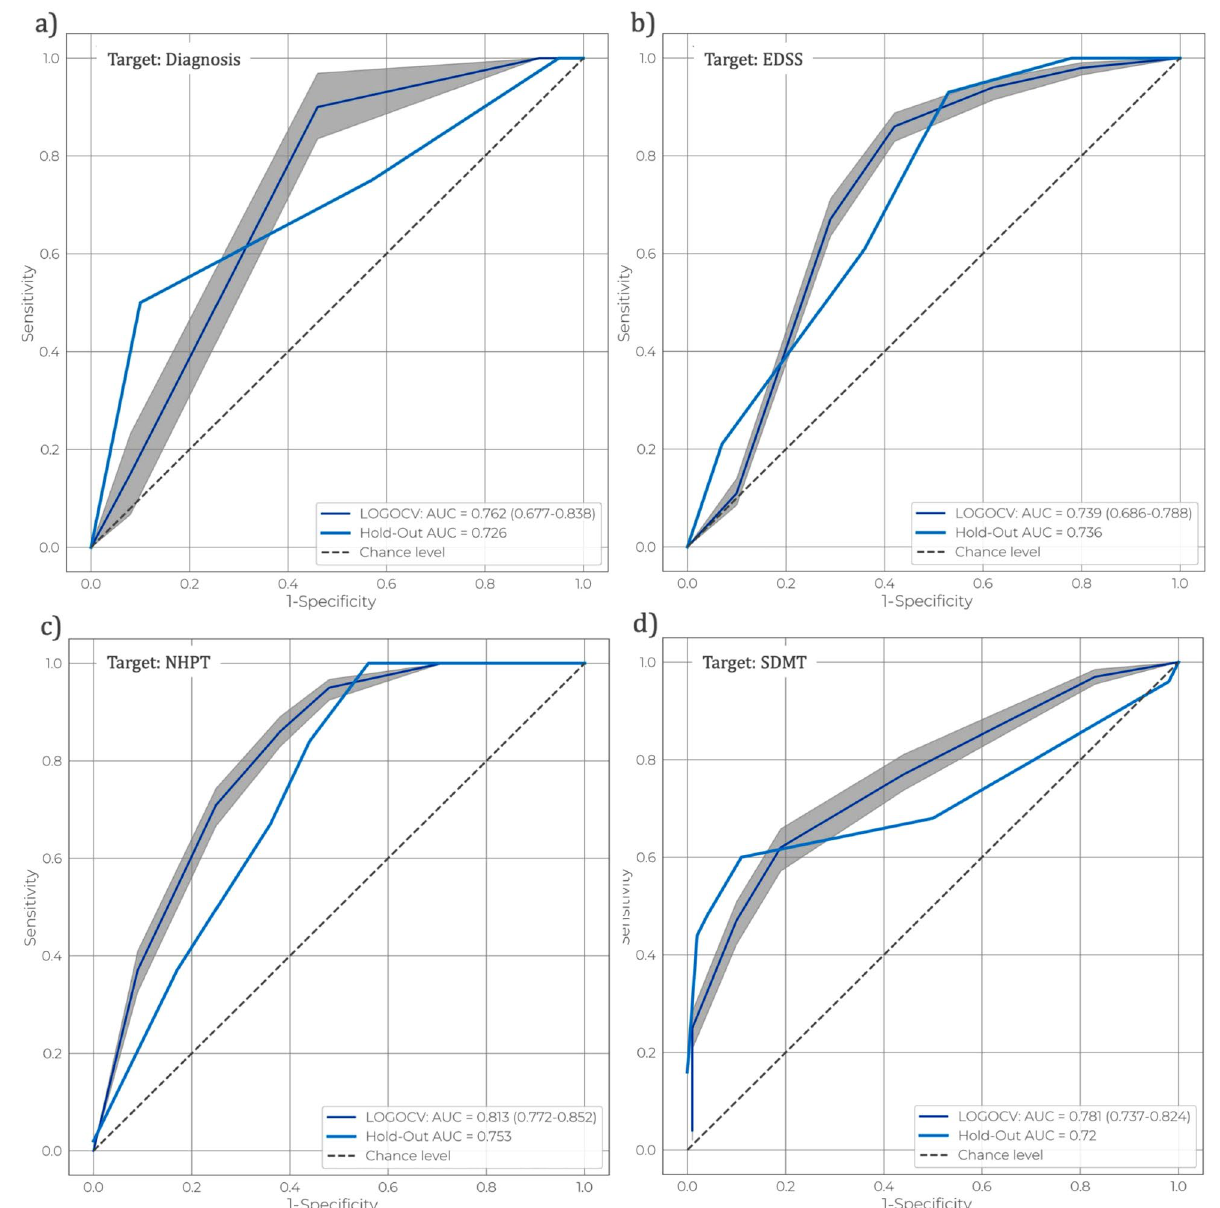
Figure 5. The mean AUC-ROC with the 95% confidence interval, computed over 1.000 bootstraps within the LOGOCV set, and the corresponding AUC-ROC carried out in the hold-out set, both coming from the best performing pipeline relative to each clinical